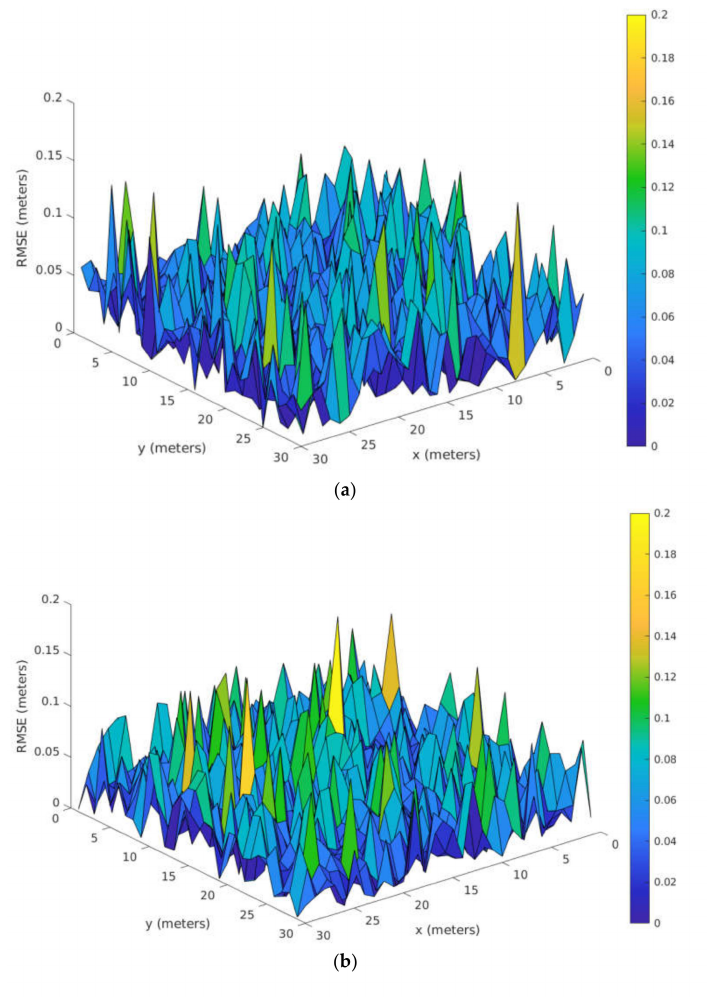
Figure 7. RMSE of the passive station when the reference station is placed ( a ) at (1,1); ( b ) at (14,14). AP fixed at (15,15), and sample-set of length